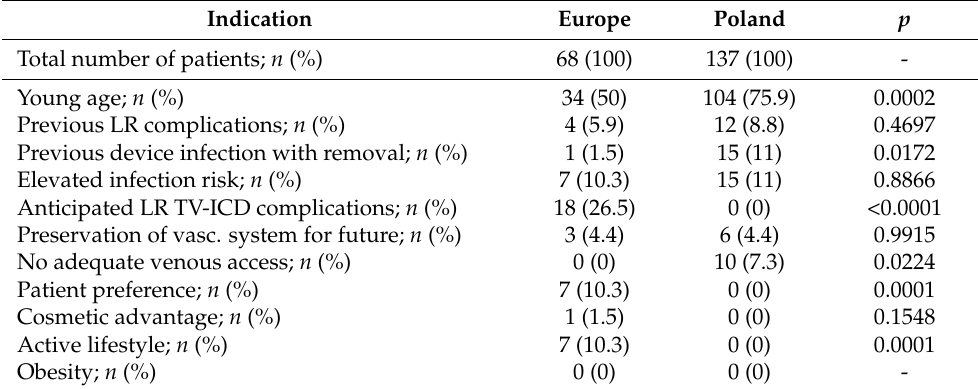
Table 3. Comparison of indications for a subcutaneous cardioverter-defibrillator between the study group and the ESSS-SICDI group—J˛edrzejczyk–Patej et al.